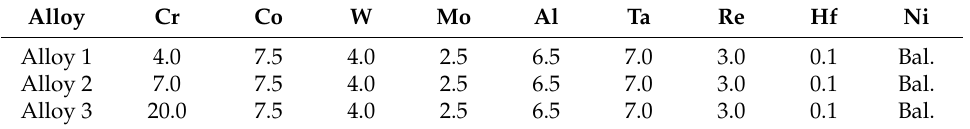
Table 1. Composition (wt.%) of alloys used in the